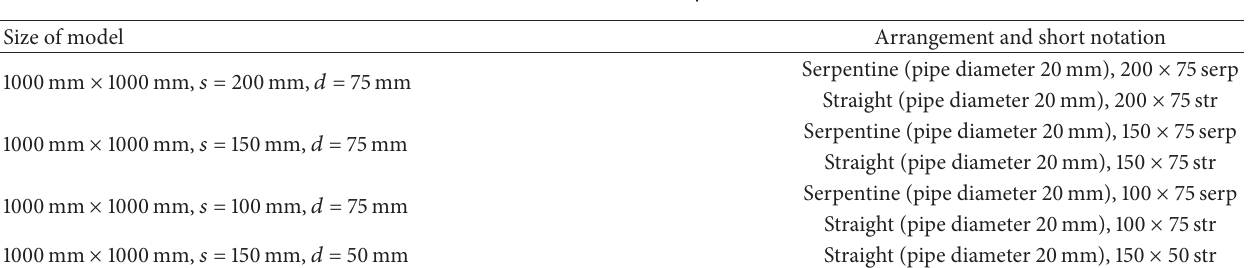
Table 4: Models analysed.